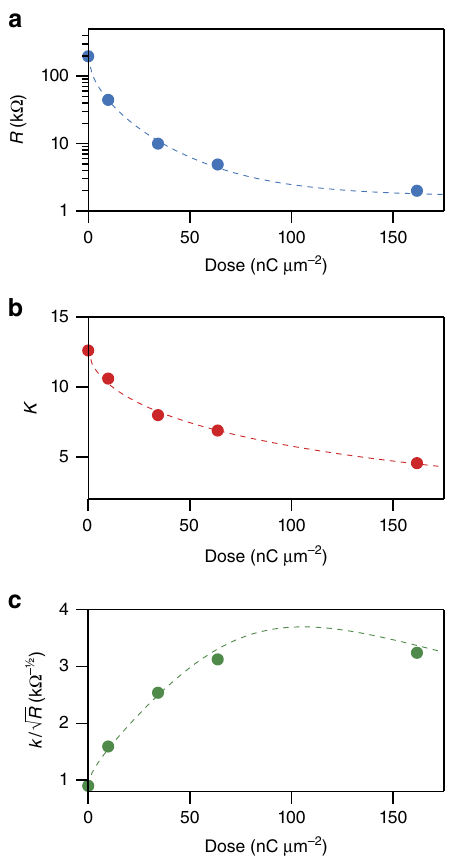
Figure 2 | Signal-to-noise ratio optimization of nanogranular tunnelling resistor sensors. ( a ) Measured reduction of resistance R of typical nanogranular tunnelling resistor (NTR) strain sensor element (active sensor element size 4 (cid:4) 2 (cid:4) 0.2 m m 3 ) versus effective post-growth electron irradiation dose. Within the applied dose range transport remains in the inelastic co-tunnelling regime (see dashed ellipse in Fig. 1d). ( b ) Associated measured drop of NTR gauge factor k versus irradiation dose. ( c ) Calculated dose-dependent signal-to-noise ratio as a consequence of its k /R 1/2 dependence given in equation (1). The dashed lines serve to guide the threshold electric field of at least 15 kV cm (cid:3) 1 , beyond which local heating effects lead to the deviation from linearity (see Supplementary Figs 3–4 and Supplementary Note 3 for details).